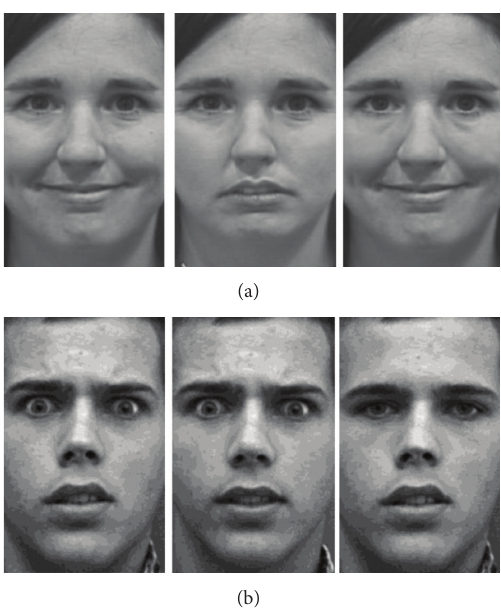
Figure1:Representativesamplestimulusofbottom-emotionhappi- ness (a) and top-emotion fear (b), from left to right: original expres- sion, hybrid expression with neutral mouth, and hybrid expression with neutral eyes (the pictures used in our paper are part of the Cali- fornia Facial Expression database, which is freely available online for research purpose. For more information regarding this database, we referyoutotheirwebsite:http://cseweb.ucsd.edu/users/gary/CAFE/